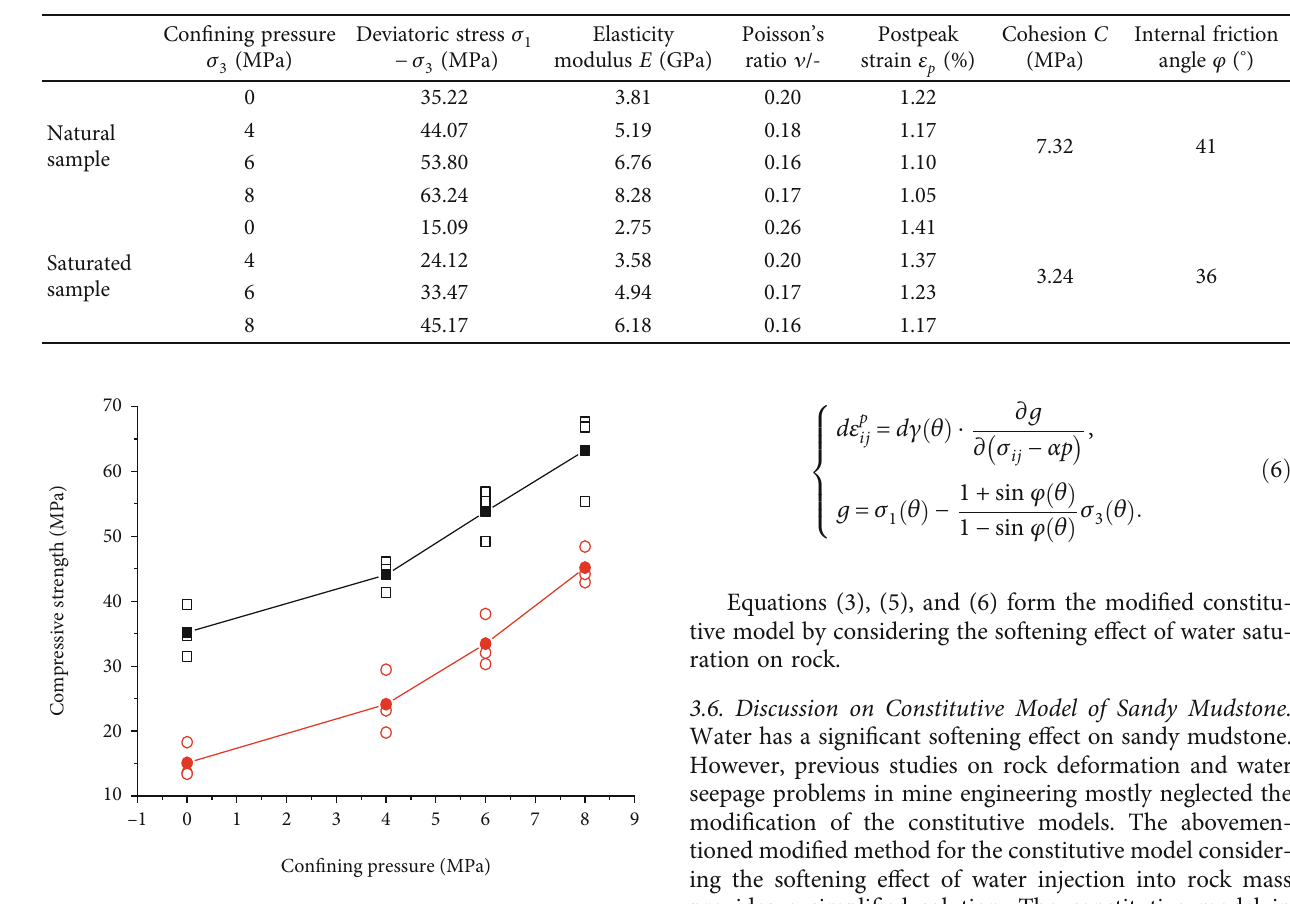
Table 1: Mechanical parameters of natural and fully saturated sandy mudstone.